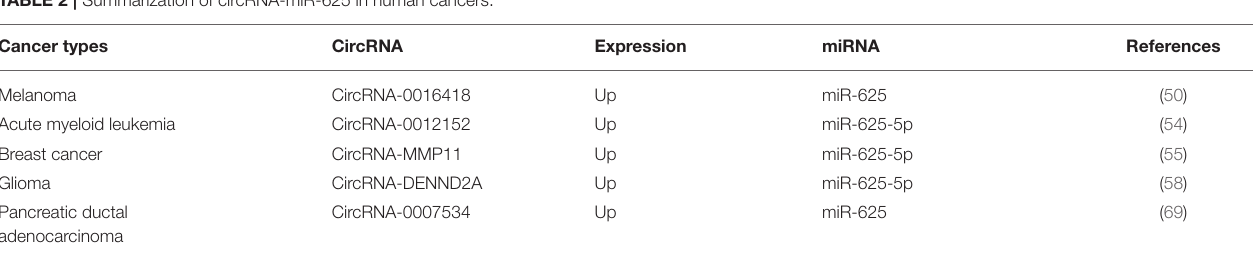
TABLE 2 | Summarization of circRNA-miR-625 in human